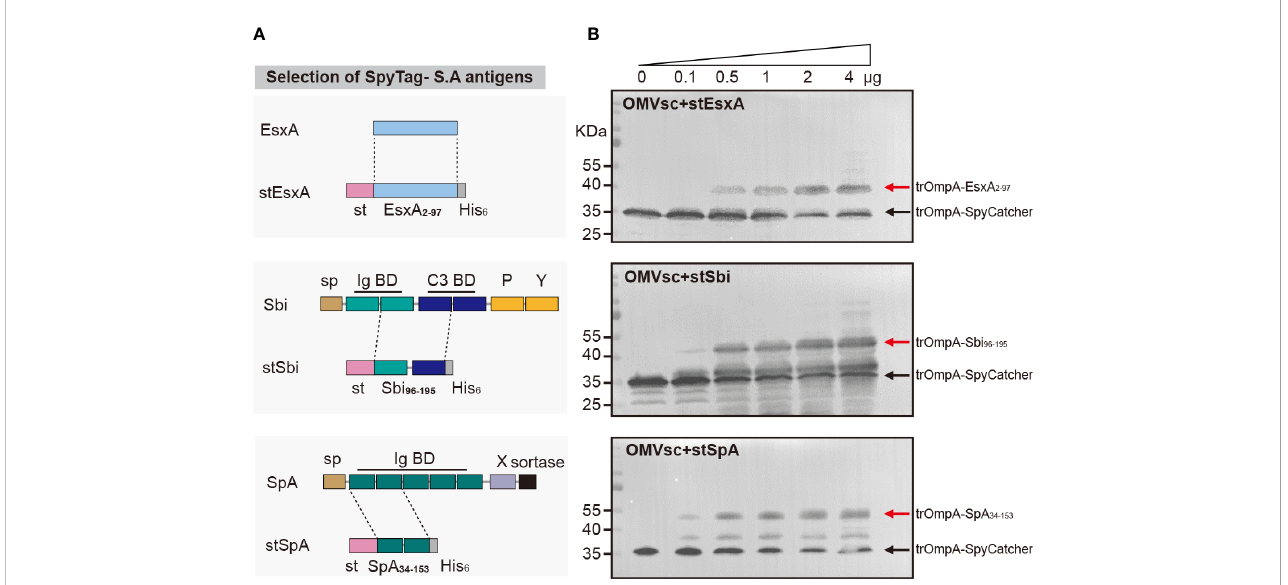
FIGURE 3 Decoration of engineered OMVs with heterologous S. aureus antigens. (A) Schematic representation of the selection of the recombinant S. aureus